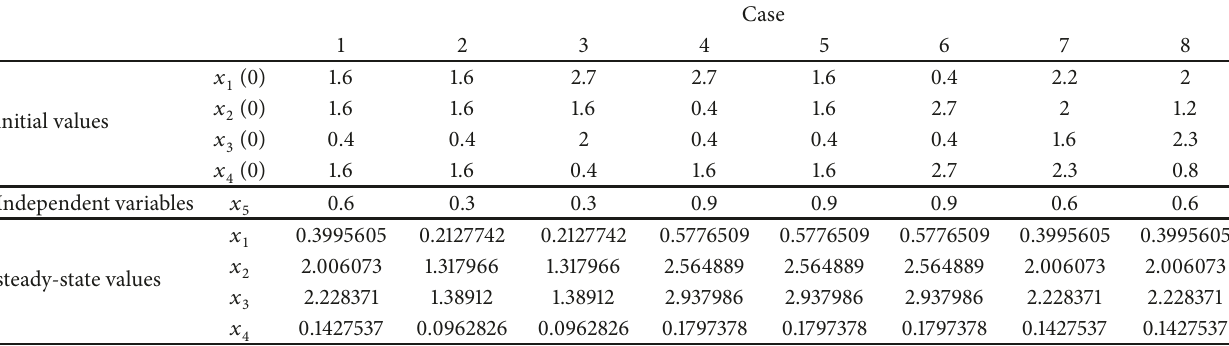
Table 1: Steady state values of the branch pathway.